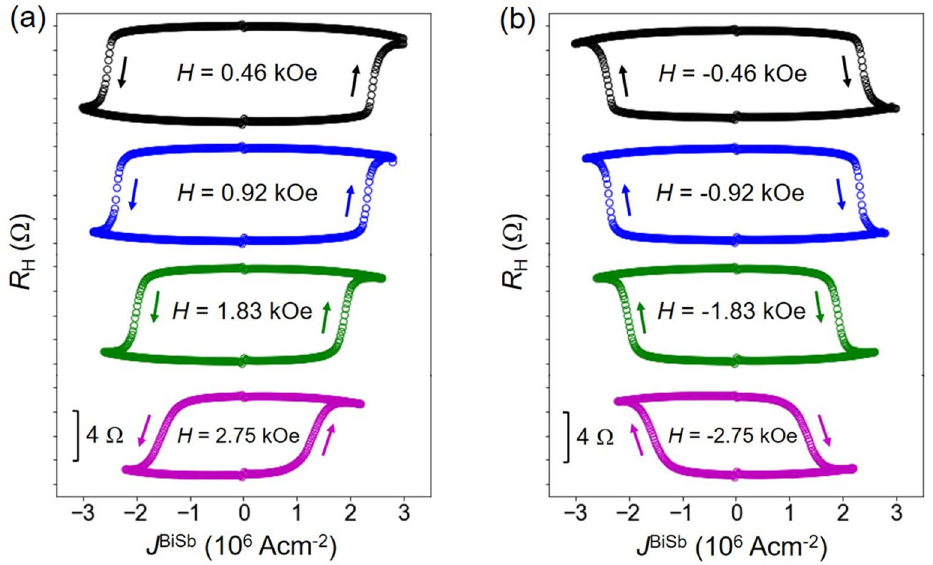
Figure 3. SOT magnetization switching by DC currents. Switching loops measured under an in-plane magnetic field applied along ( a ) + x direction and ( b ) − x